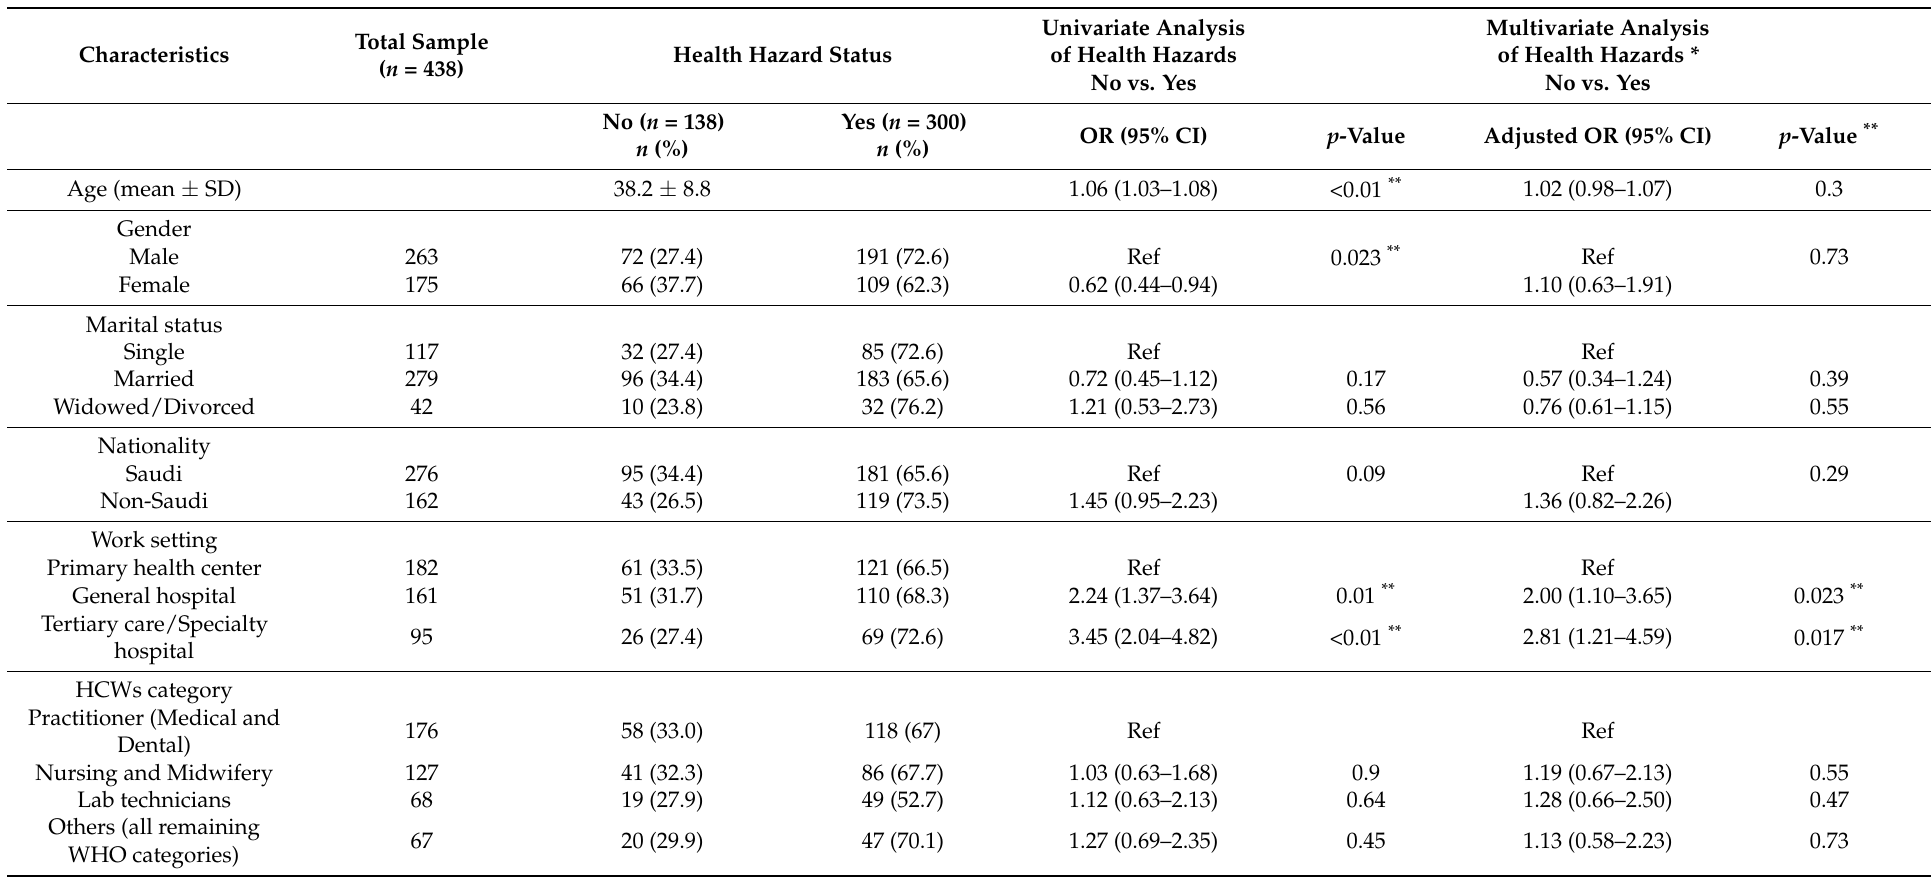
Table 3. Biological health hazards and their association with socio-demographic and lifestyle-related